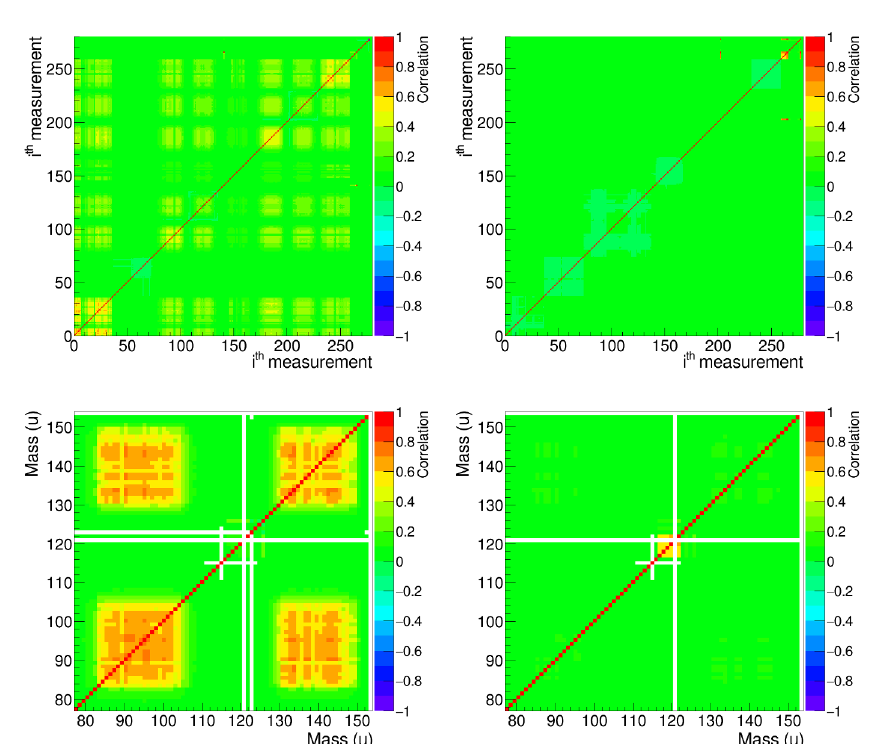
Figure 1. Preliminary results. (up, left) Cross-correlations for 8 datasets after normalization to the 3 th set; (up, right) the same data in reference to the 4 th set. These di ff erences come from the uncertainties of the normalization factor σ ( k ij ) which are not the same in both cases (see table 2). (down) Correlation of mean mass rate Co v ( ¯ R ( A ); ¯ R ( A (cid:48) )) in reference to set 3 (left) and the set 4